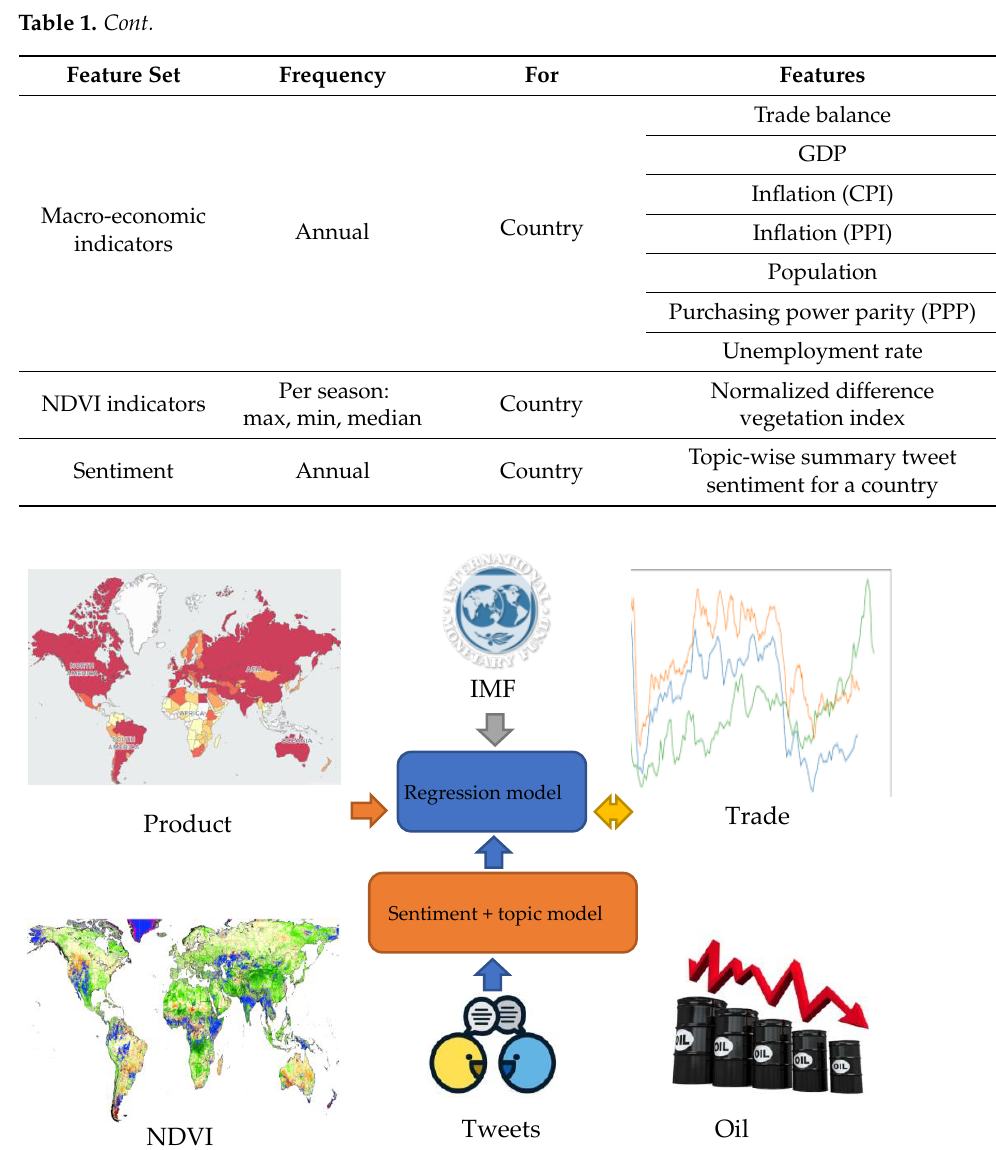
Figure 1. The data processing pipeline.